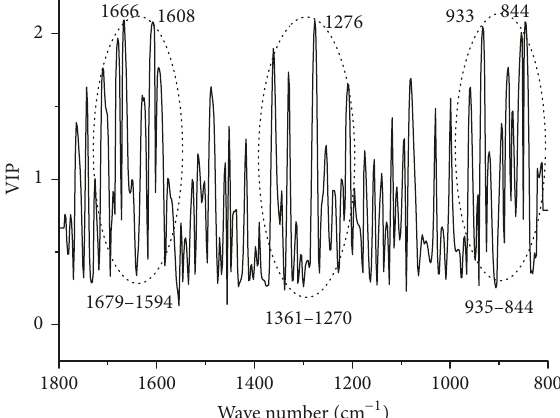
Figure8:TheVIPplotofPLSRmodel.(Description:thisplotisused to identify the bands which are higher related to the determination of gentiopicroside in the regression